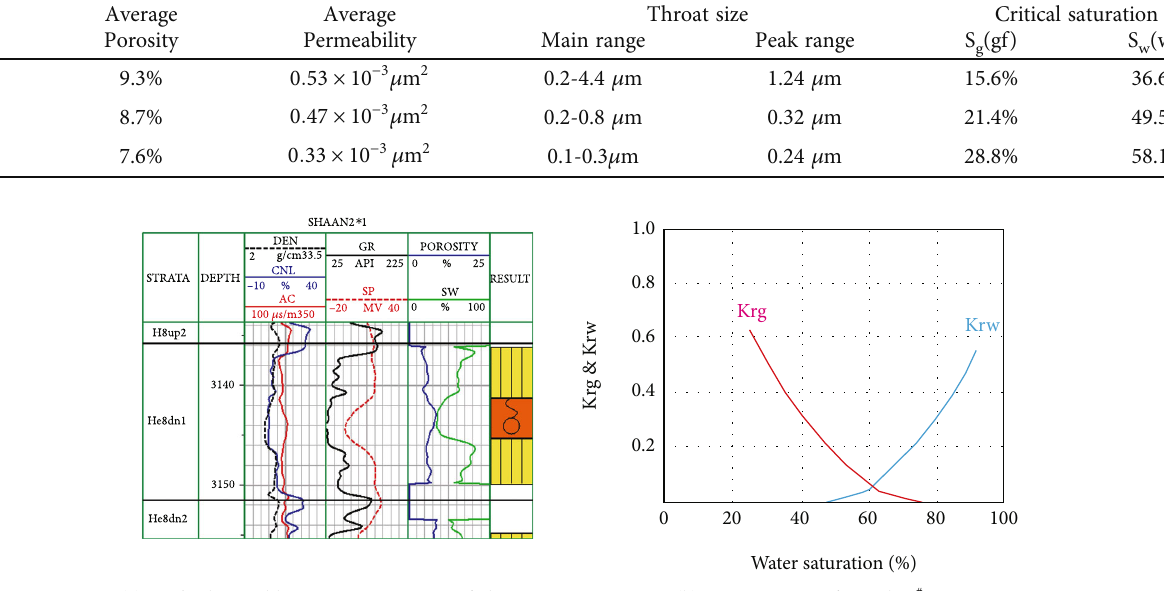
Figure 7: He8 ’ s electrical logging interpretation and seepage curve of Shaan2 ∗ 1. (a) He8 ’ s electrical logging interpretation of Shaan2 ∗ 1. (b) Seepage curve of sample 4 # .